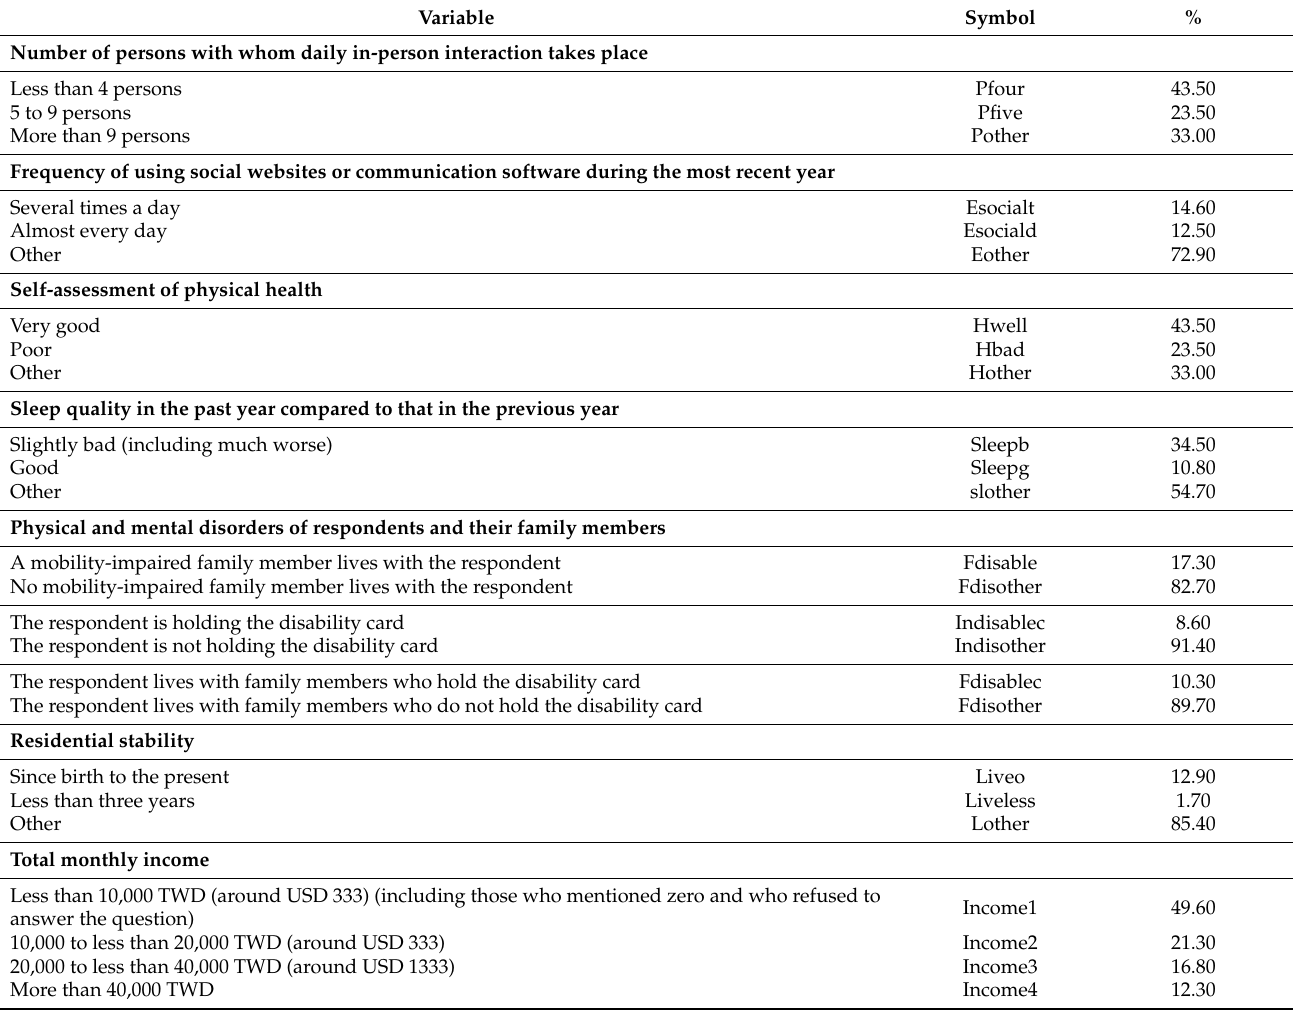
Table 1. Explanatory variables, symbols, and response